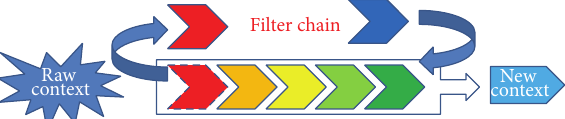
Figure 3: Pluggable ordered filter chain mechanism.